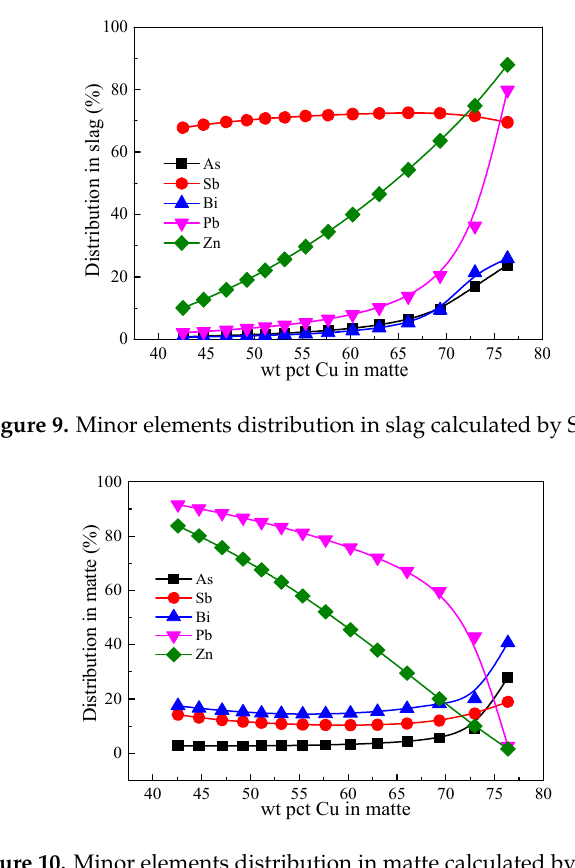
Figure 10. Minor elements distribution in matte calculated by SKSSIM.